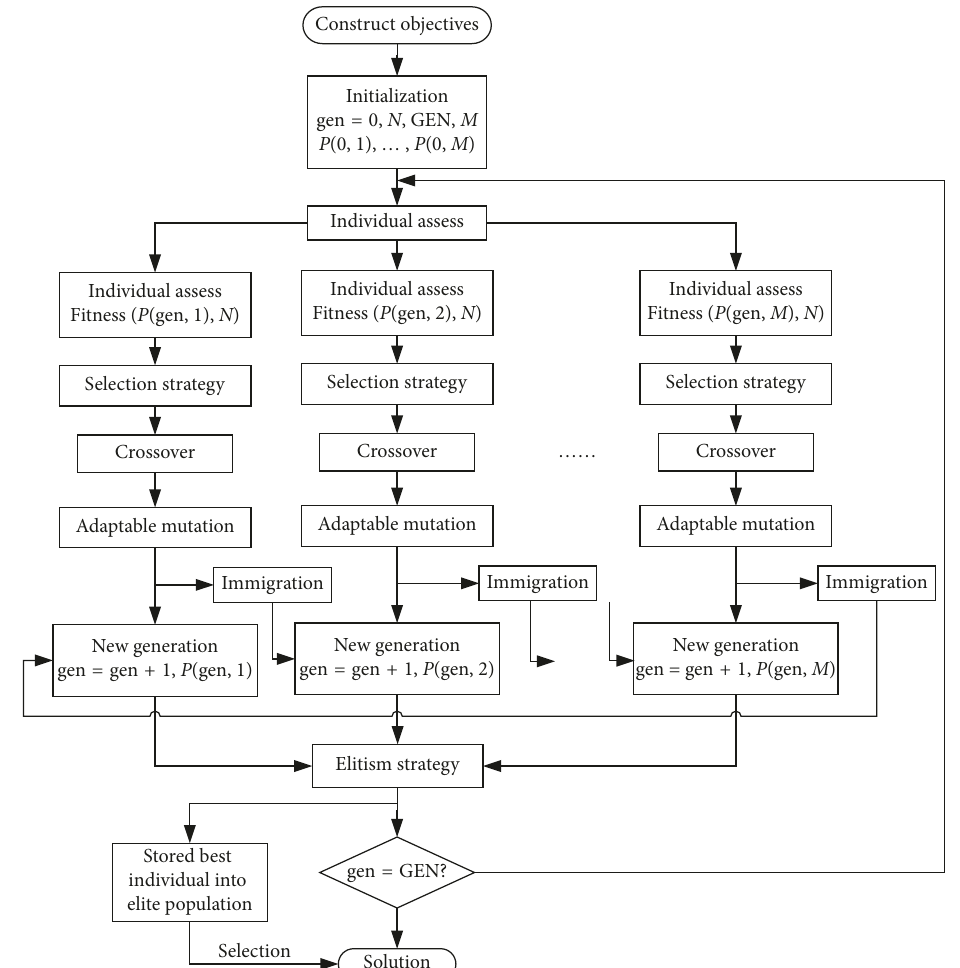
Figure 2: Framework of